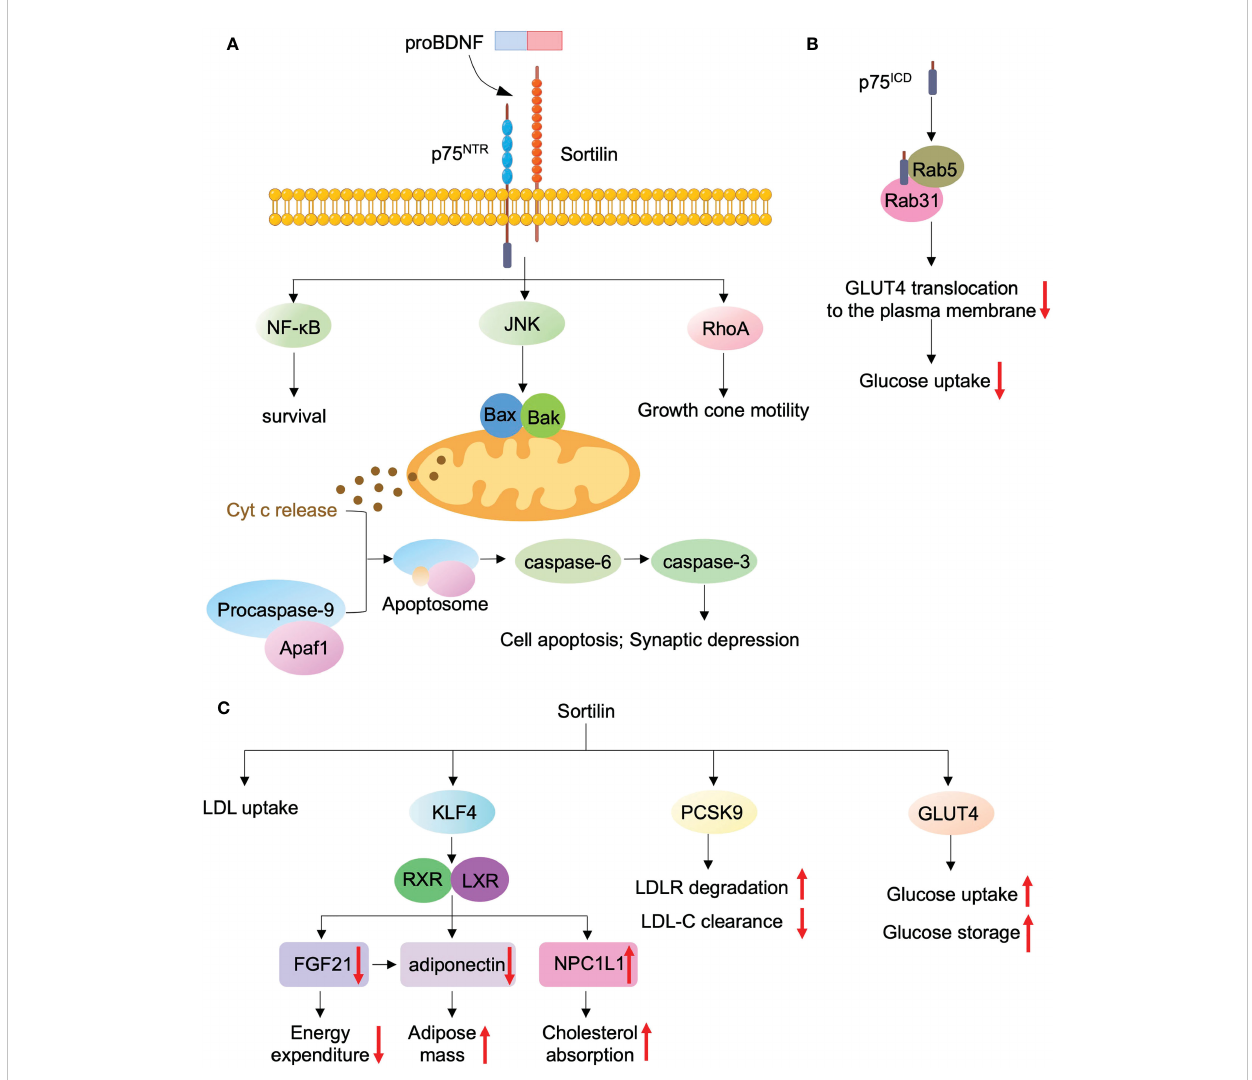
FIGURE 2 ProBDNF and their receptors mediate the regulation of metabolism and mitochondria. ProBDNF binds speci fi cally to p75 NTR through interaction with sortilin, which induces JNK signaling to increase the release of cytochrome C from mitochondria and promote cell apoptosis and synaptic depression. ProBDNF binds p75 NTR and sortilin promotes growth cone motility and cell survival via activating RhoA and NF- k B, respectively (A) . P75 ICD forms a complex with Rab5 and Rab31 GTPases to enhance glucose uptake via promoting GLUT4 translocation to the plasma membrane (B) . Sortilin also enhances LDL uptake and LDLR degradation, whereas decreases clearance of LDL-C. Sortilin promotes glucose uptake and storage via interacting with GLUT4 (C)